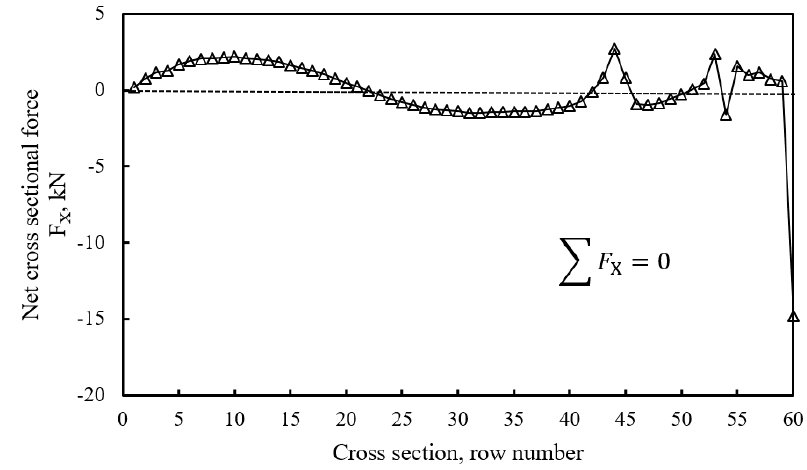
Figure 6. Cross-sectional force equilibrium condition in the X direction.